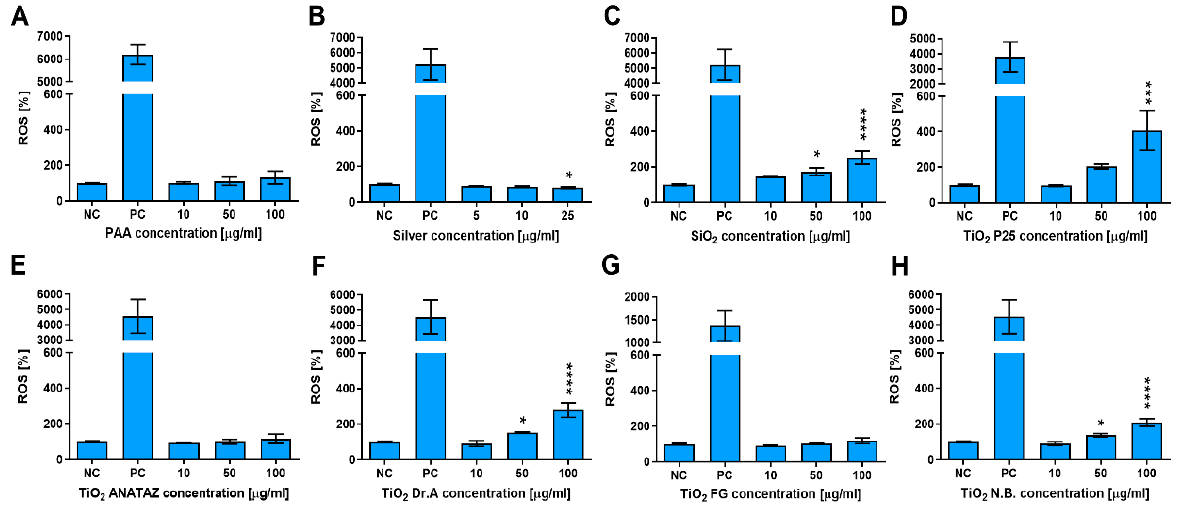
Figure 6. ROS induction in THP-1 macrophages following 24 h incubation with increasing concentrations of ( A ) polyacrylic acid (PAA)-coated NPs, ( B ) silver NPs, ( C ) engineered SiO 2 NPs, ( D ) TiO 2 P25, ( E ) TiO 2 ANATAZ NPs, ( F ) TiO 2 DrA NPs, ( G ) TiO 2 food-grade (FG), and ( H ) TiO 2 N.B. NPs, as determined with CM-H 2 DCFH-DA assay. For the positive control (PC), cells were incubated with 1 mM H 2 O 2 for 20 min. Please note that lower concentrations were used for silver NPs. Mean and standard error of three independent experiments are shown. Statistical significance is displayed as follows: ns ( p > 0.05); * p ≤ 0.05; *** p ≤ 0.001, **** p ≤ 0.0001.